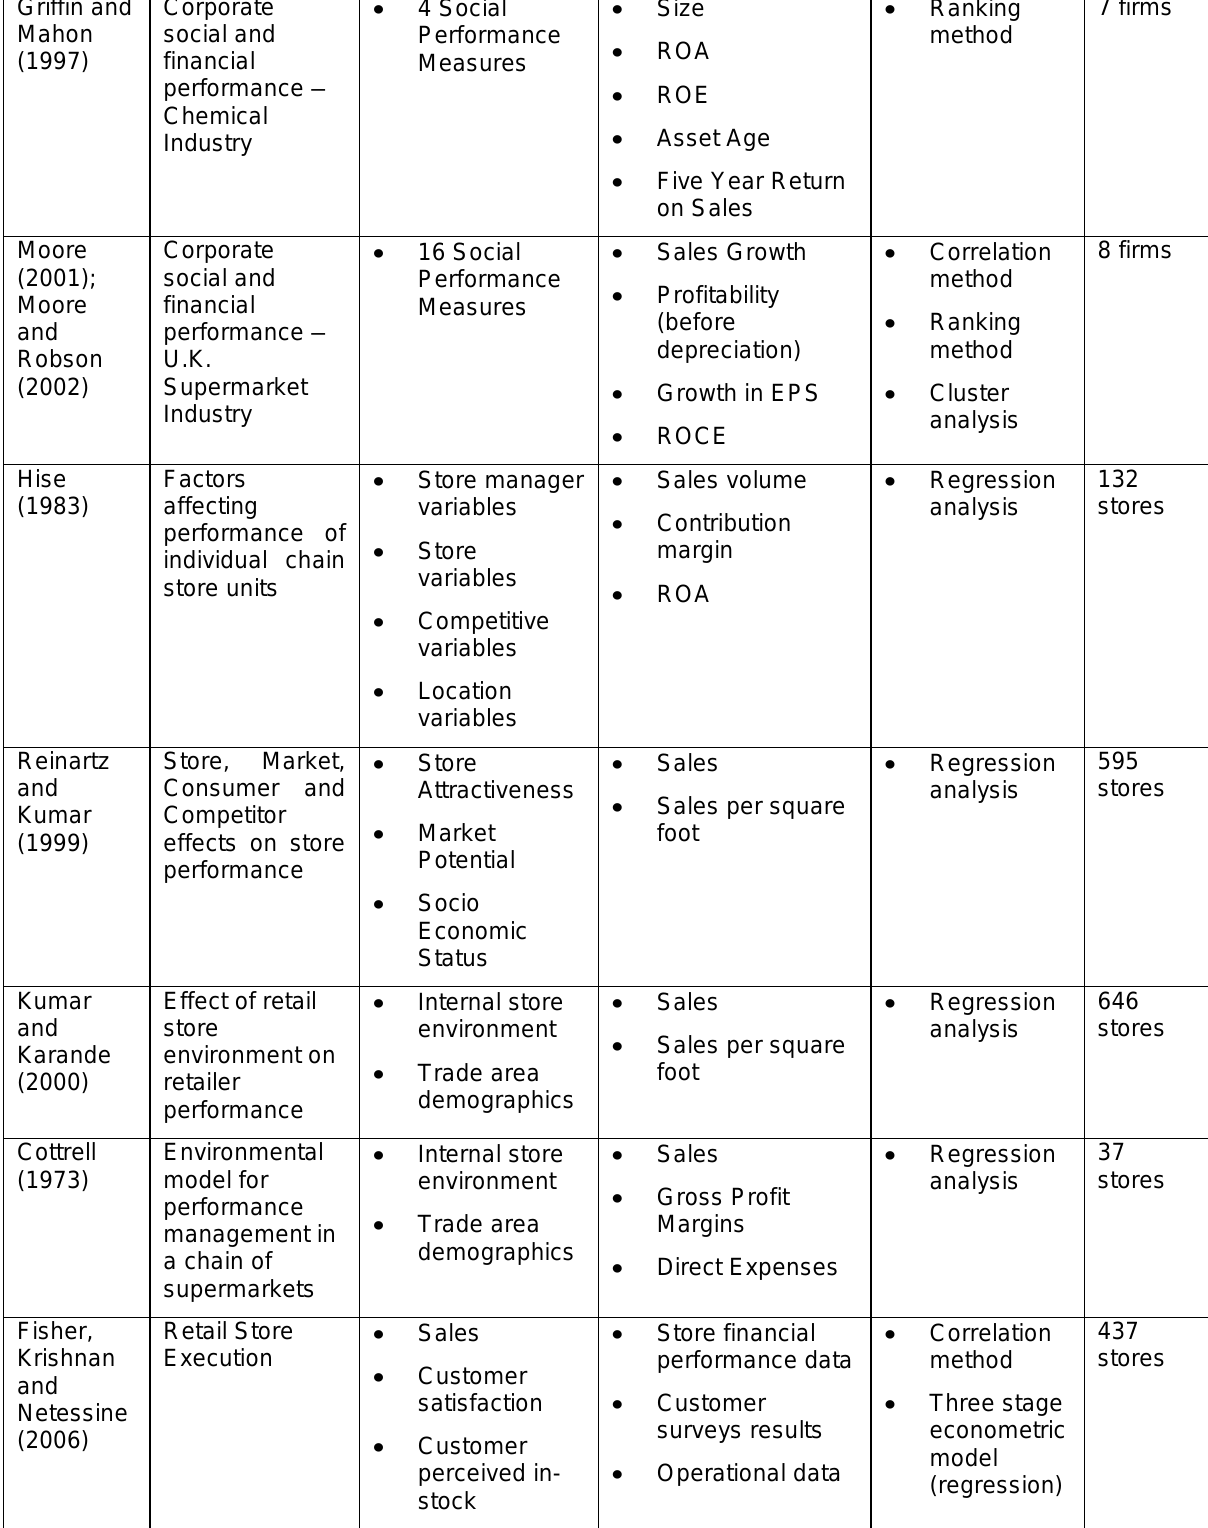
Table 1: Summary of literature review on retail store performance